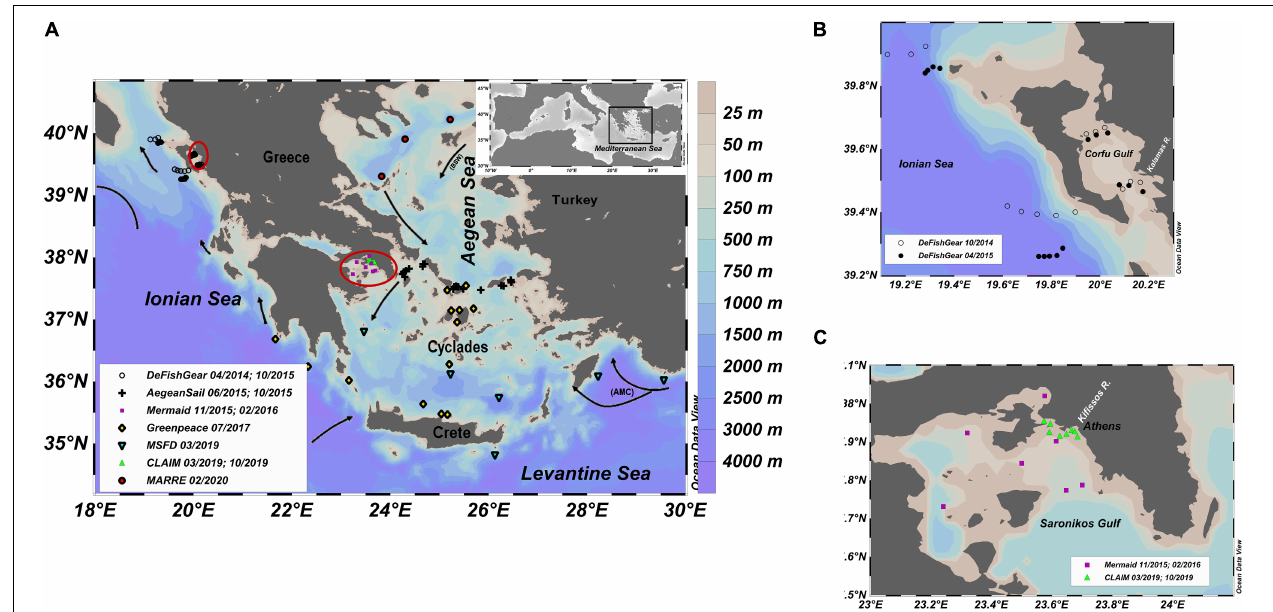
FIGURE 1 | Map of sampling positions in the Ionian, Aegean, and Levantine Seas for each of the seven campaigns from April 2014 to February 2020. In red circles the two enclosed gulfs sampled (A) . Sampling positions in Corfu Gulf (B) and Saronikos Gulf (C) . Black arrows denote surface